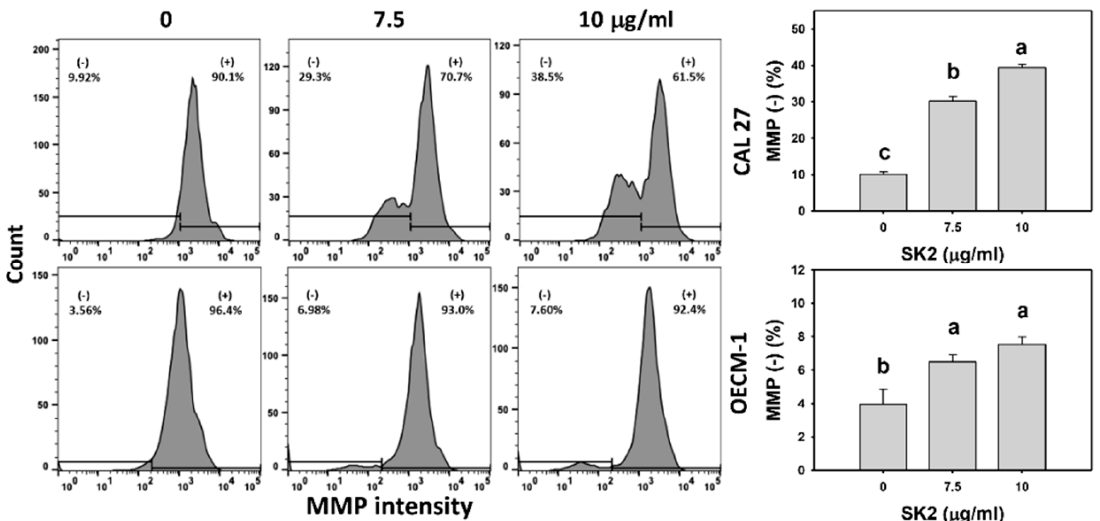
Figure 7. SK2 prompts MMP destruction in oral cancer cells. MMP detections and statistics are pro- vided. Cells were exposed to SK2 (0 (0.1% DMSO), 7.5, and 10 µg/mL) for 24 h. ( − ) in each panel represents MMP ( − ). Data (means ± SDs; n = 3) without overlapping characters differed significantly ( p < 0.05). For an example of CAL 27 cells, different concentrations with different characters indicate significant differences. For an example of OECM-1 cells, for SK2 at 7.5 and 10 µg/mL, the same letter “a” indicates non-significant differences because the results overlapped. For CAL 27 cells, for SK2 at 0, 7.5, and 10 µg/mL, “c, b, and a” indicate significant differences because the results did not overlap. For OECM-1 cells, for SK2 at 7.5 and 10 µg/mL, “a and a” indicate the results are not sig- nificantly different because they overlapped.